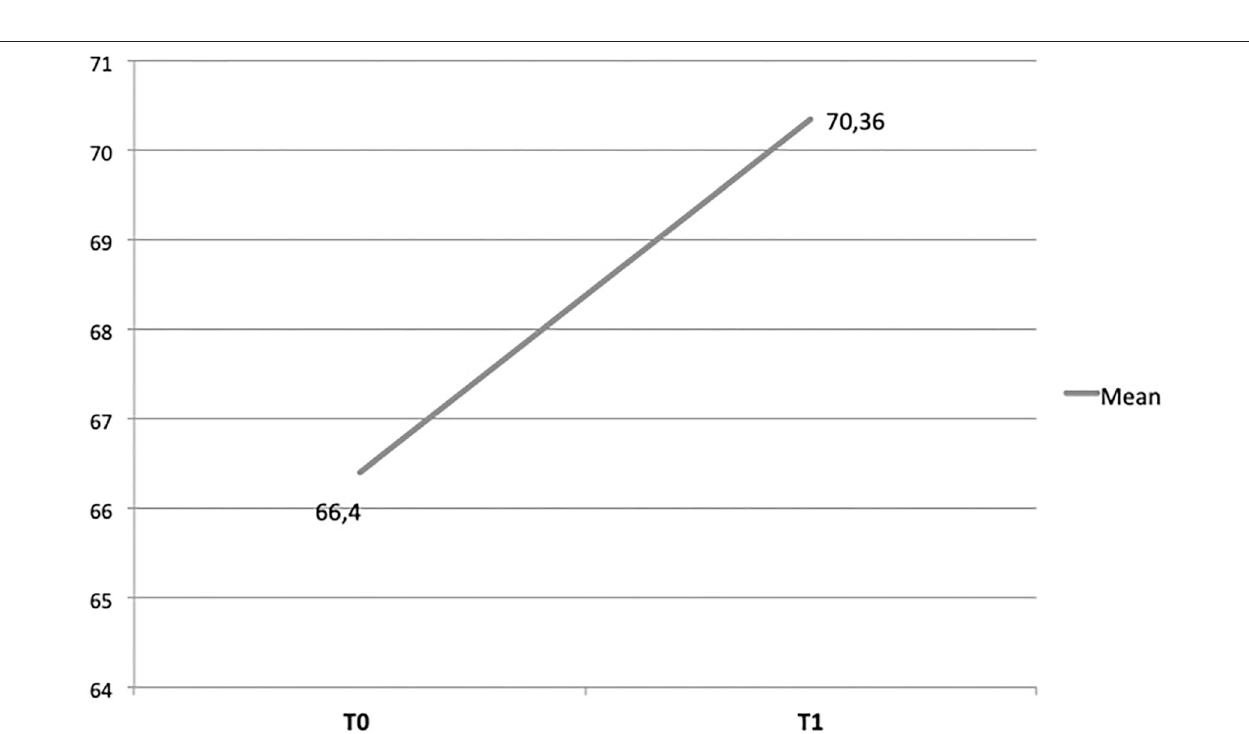
FIGURE 3 | Change of trainees’ self-efficacy paralleled with the ToR.